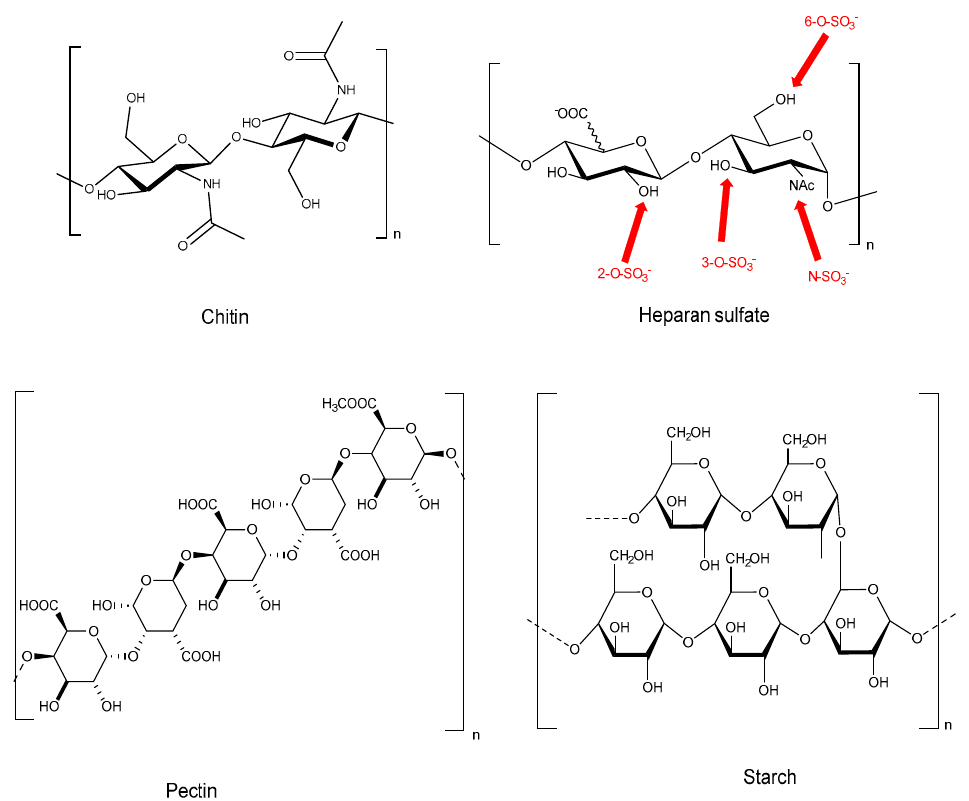
Figure 1. Examples of some natural polysaccharides.